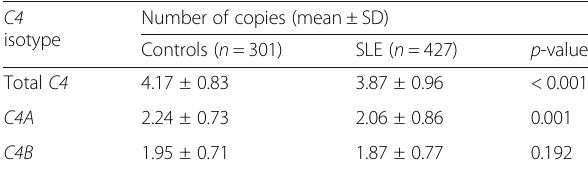
Table 2 Gene copy number of total C4 , C 4A and C 4B in SLE and